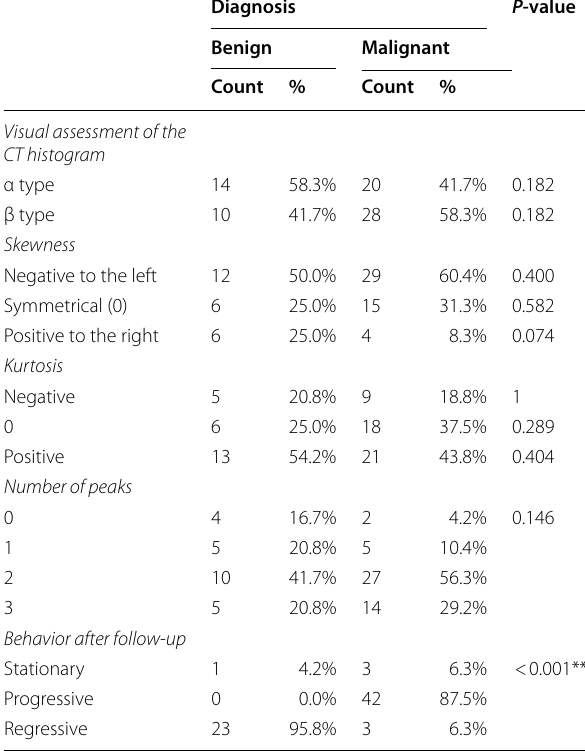
Table 4 Relation between data analysis of the histogram and follow‑up behavior of the segmented neoplastic and non‑ neoplastic pulmonary